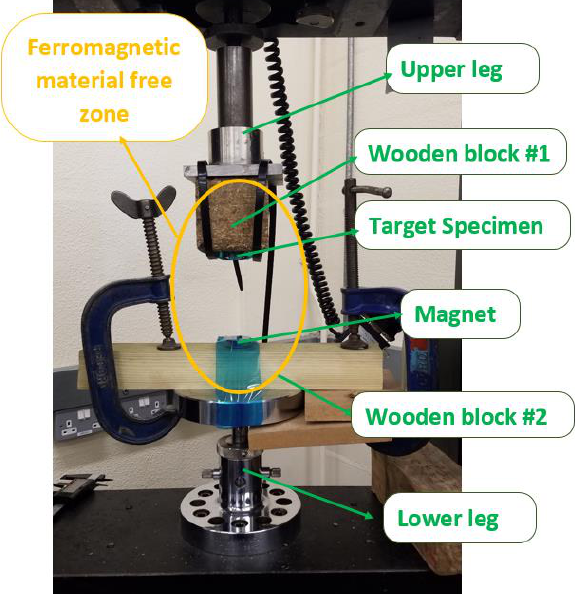
Figure 5. Experimental setup of testing the magnetic force as a function of distance on an Instron Dual Column Tabletop Testing System, with a mild steel and a silver steel target specimen against a 24 kg pull-force N52 neodymium disk magnet.